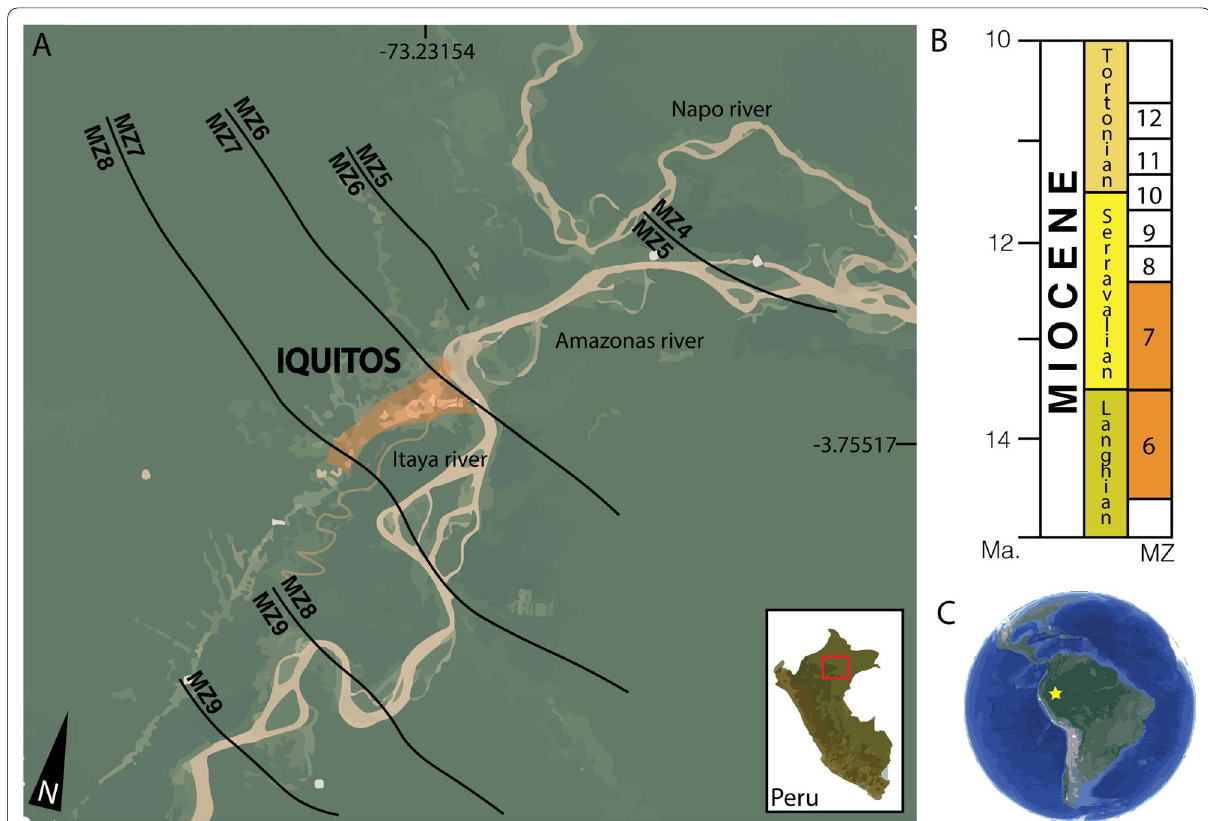
Fig. 1 Geographic and geological context of the Iquitos city in Loreto, Peru. A , C . Map of the Iquitos vicinity, indicating the Mollusks zones (MZ) beds across the Amazon River exposures in the region, and localization of the region within the context of South America. B . Geological setting, including the molluscan zonification by Wesselingh